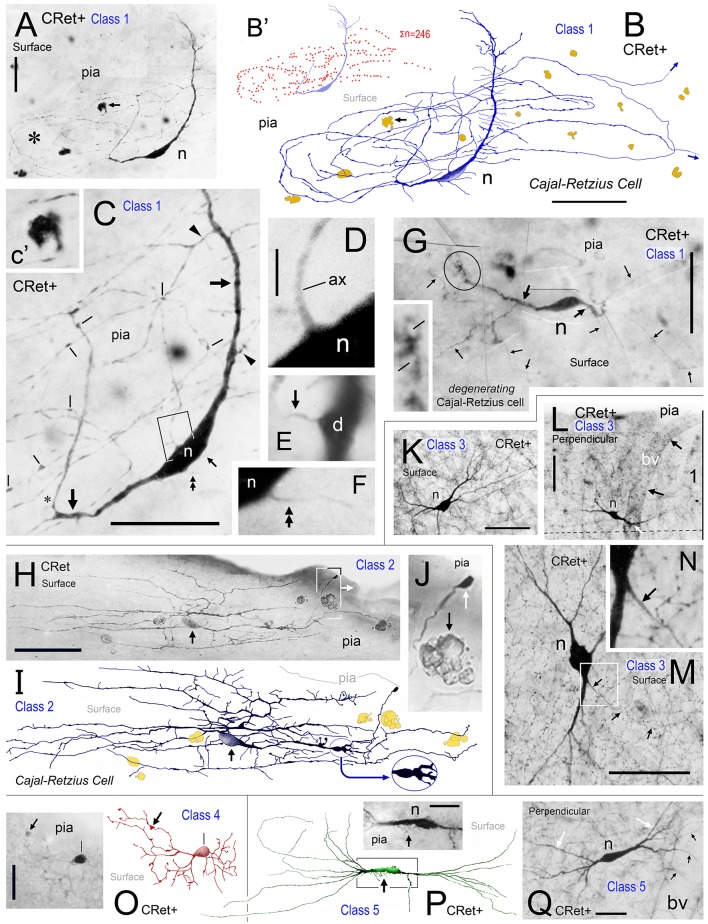
Calretinin immunopositive (CRet+) neurons in layer 1 of monkey PFC — Classes 1–5. (A) Class 1. Area 32. Surface view of a superficial horizontal fusiform CRet+ neuron (n) lying immediately below the pial surface. Note the widespread distribution of labeled processes which ramified throughout the depth of layer 1 (asterisk). A deposit of cellular debris (non-immunolabeled) is indicated (small arrow). Montaged photograph. Scale bar: 25 μm. (B) Reconstruction of the CRet+ neuron seen in (A). Thick dendrites emerge from opposite ends of the highly fusiform soma. Numerous thin varicose processes arise from dendrites and ramify radially to form a swirling varicose plexus in the vicinity of the soma and its main dendrites. Two labeled processes that course distally before being truncated (small arrows). This neuron is immunomorphologically identified as a Cajal-Retzius cell. Scale bar: 50 μm. (B′) Distribution of individual axonal swellings (red dots) along the immunolabeled processes of the cell seen in (A,B). Scale bar: 50 μm. (C) Detail of the perisomatic region of the CRet+ neuron in (A). Note the thick primary dendritic processes (arrows) and the numerous side shoots (triangles). Varicosities/swellings along the labeled processes are indicated (lines). Scale bar: 40 μm. (C′) High power image of the cellular debris indicated in (A). (D) Enlargement of the boxed region in (C) showing a main axon-like process (ax) arising from the labeled soma (n). Scale bar: 5 μm. (E) Labeled thin caliber process (arrow) arising from a main dendritic process (D). (F) Labeled thin process (double headed arrow; see C) emerging from the soma (n). (G) Class 1. Area 24b. Surface view of a degenerating bipolar CRet+ neuron (n) in upper layer 1 with dysmorphic dendrites and processes (thick arrows). Vacuoles are present in a segment of one primary dendrite (encircled and shown enlarged in inset). Labeled thin collateral processes arising from the main dendrites are indicated (thin arrows). This neuron has the morphological hallmarks of a Cajal-Retzius cell. Scale bar: 60 μm. (H) Class 2. Area 32. A horizontal multipolar CRet+ neuron with an expansive elongated dendritic arbor in upper layer 1. Cell body (arrow). Highlighted regions shown in (I,J), respectively. Note the clumps of lipofuscin-rich debris (see J). (Oblique view). Scale bar: 100 μm. (I) Reconstruction of the CRet+ cell in (H). The parent dendrites bifurcate into long daughter segments forming an elongated dendritic arbor. Large varicosities along dendrites (oval inset) and the labeled process with a subpial terminal expansion (boxed region) are highlighted. (Clumps of lipofuscin-rich debris shown in dark yellow). This cell has the morphological hallmarks of a Cajal-Retzius cell. (J) Enlarged image showing the subpial terminal expansion (white arrow) and a clump of lipofuscin-rich debris (black arrow) in (H). (K) Class 3. Area 9. Surface view of a standard multipolar CRet+ cell (n) in mid-layer 1. Scale bar: 50 μm. (L) Class 3. Area 46d. Perpendicular view of a standard multipolar CRet+ cell (n) in lower layer 1 near the border with layer 2 (dashed line). Note proximally bifurcating dendritic trees. A blood vessel (bv) is seen descending perpendicularly through the cortex (black arrows). One of the CRet+ labeled dendrites sends branches around the vessel (white arrow). Scale bar: 50 μm. (M) Class 3. Area 32. Surface view of a standard multipolar CRet+ neuron (n) in mid/lower layer 1. Note axonal process (arrows). Scale bar: 50 μm. (N) Initial segment of the axon from neuron in M. (O) Class 4. Area 25. A small-sized neurogliaform CRet+ neuron in upper layer 1. Note dense plexus of immunolabeled dendrites (arrow). Scale bar: 25 μm. (P) Class 5. Area 46v. Surface view of a spindle-shaped CRet+ neuron in upper layer 1 with a tuft of dendrites originating from opposite poles of the soma. Inset: numerous fine fibers emerging from the labeled soma (arrow). Scale bar: 20 μm. (Q) Class 5. Area 24b. Perpendicular view of a spindle-shaped CRet+ neuron in mid-layer 1 with tufts of dendrites (white arrows). Several dendrites (black arrows) wrap around a neighboring blood vessel (bv). Scale bar: 20 μm.